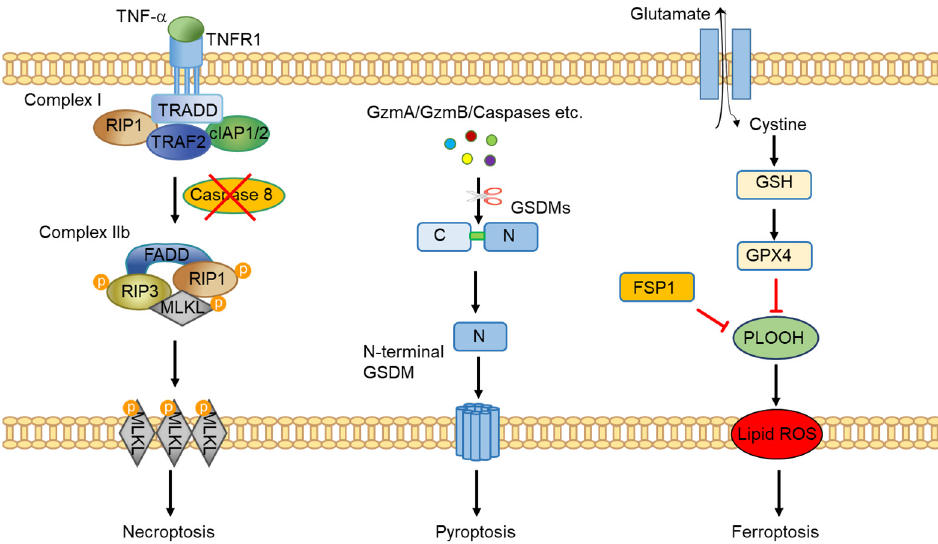
Figure 1. Key programmed necrosis pathways. The classical necroptotic pathway is activated by TNF stimulation. TNF binds to TNFR1 and leads to the formation of complex I. In the absence of caspase 8 activity, RIP1 interacts with RIPK3, FADD and MLKL to form complex IIb, which mediates necroptosis. Pyroptosis has been considered as gasdermin-mediated necrosis. Endogenous caspases and lymphocyte-derived Granzyme A/Granzyme B are able to cleave and activate individual gasdermins (GSDM) which further triggers pyroptosis. Ferroptosis is a failsafe rather than a typical cell death pathway. GPX4 and FSP1 prevent lipid peroxidation which is key to drive ferroptosis.